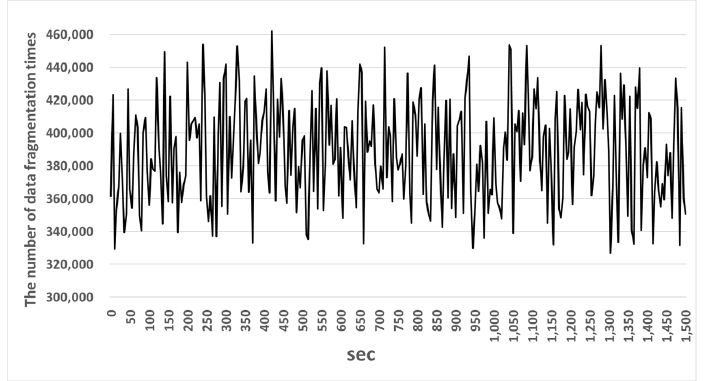
Figure 14. The number of data fragmentation times in the OFSG.